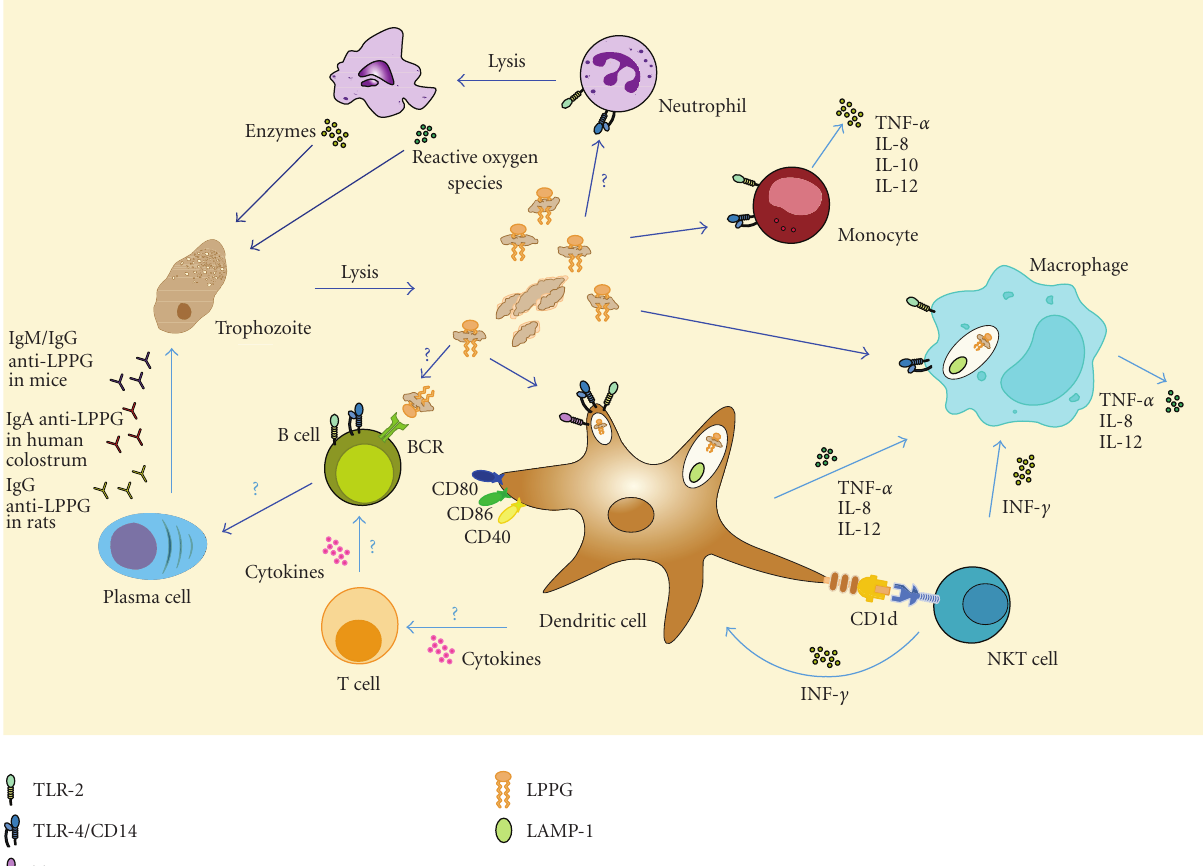
Figure 2: The role of lipopeptidophosphoglycan (LPPG) in the immune response to Entamoeba histolytica . During E. histolytica infection, amebic enzymes and enzymes and reactive oxygen species from neutrophils cause tissue damage. LPPG released from lysed trophozoites is recognized through TLR2 and TLR4/CD14 and induces the production of IL-8, IL-10, IL-12p40, and TNF-alpha by monocytes [85, 96]. Macrophages and dendritic cells internalize LPPG into LAMP-1+ endosomes, and LPPG-activated dendritic cells have increased expression of costimulatory molecules CD80, CD86, and CD40 and produce TNF-alpha, IL-8, and IL-12 [97]. NKT cells are also activated by LPPG, and this depends on the presence of CD1d on dendritic cells and simultaneous TLR2 and TLR6 signaling [58]. Anti-LPPG antibodies have been described in humans and in animal models [47–53]. The mechanism that leads to the production of these antibodies has not been determined, but it is probably influenced by the innate signaling of LPPG on dendritic cells and B